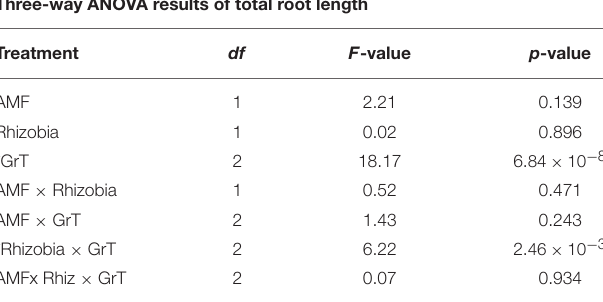
TABLE 3 | Three-way ANOVA results indicating the significance of total root length with a combination of microbial treatments, gravitational treatments (GrT) and a combination of